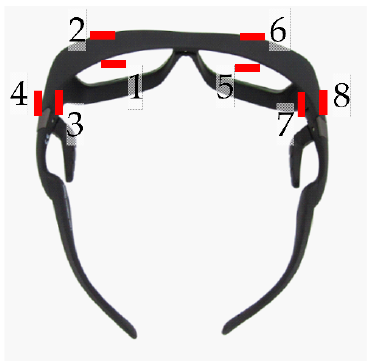
Figure 3. Locations of small dosimeters on radioprotective glasses: 1, left inside lens; 2, left outside lens; 3, left inside frame; 4, left outside frame; 5, right inside lens; 6, right outside lens; 7, right inside frame; and 8, right outside frame.